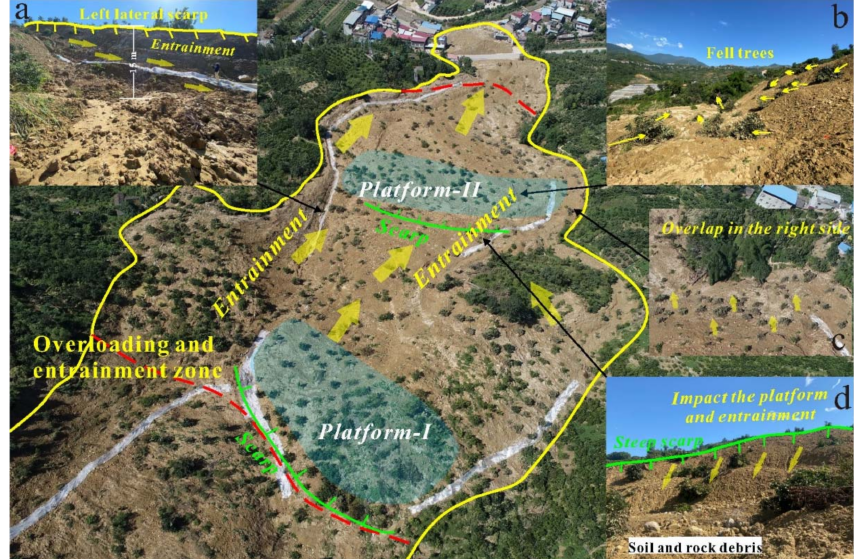
Figure 7. Overall photo and features of the entrainment area. ( a ) Lateral scarp at the left boundary. ( b ) The trees on the slope were pushed sideways. ( c ) Overlap phenomena in the right side. ( d ) Steep scarp formed after landslide in the middle